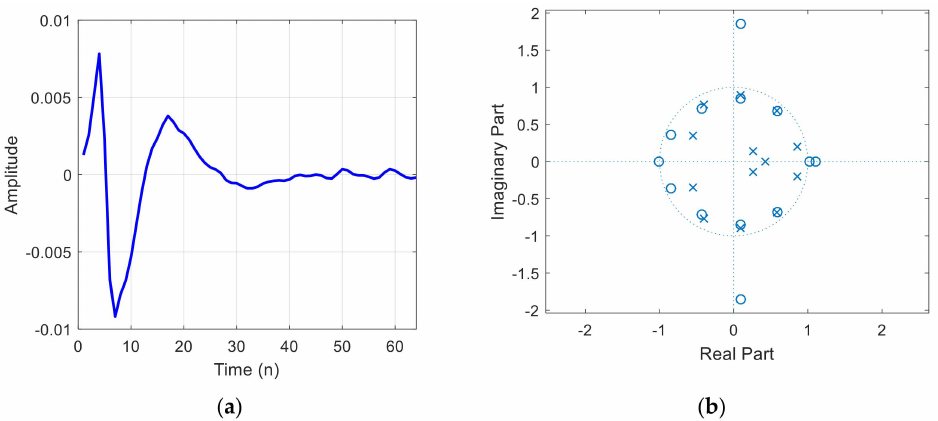
Figure 3. The identified secondary path: ( a ) impulse response and ( b ) zeros (crosses) and poles (circles)